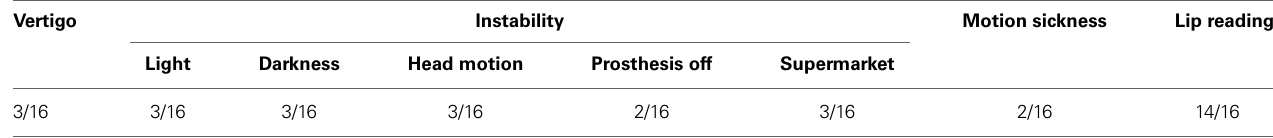
The fractions in each column indicates the number of patients among the total population (N = 16) reporting vertigo, instability or motion sickness, and the number of patients submitted to lip reading rehabilitation after CI